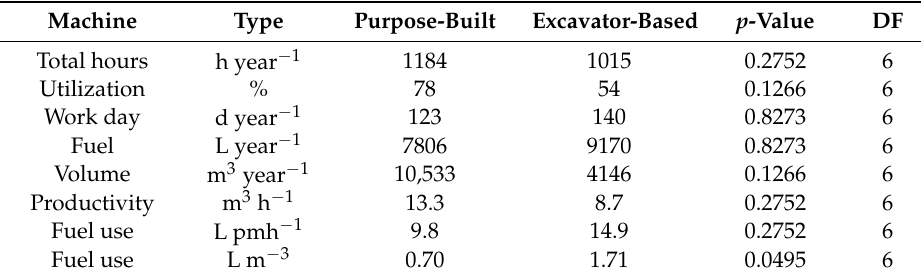
Table 3. Medians of the annual records by machine type.